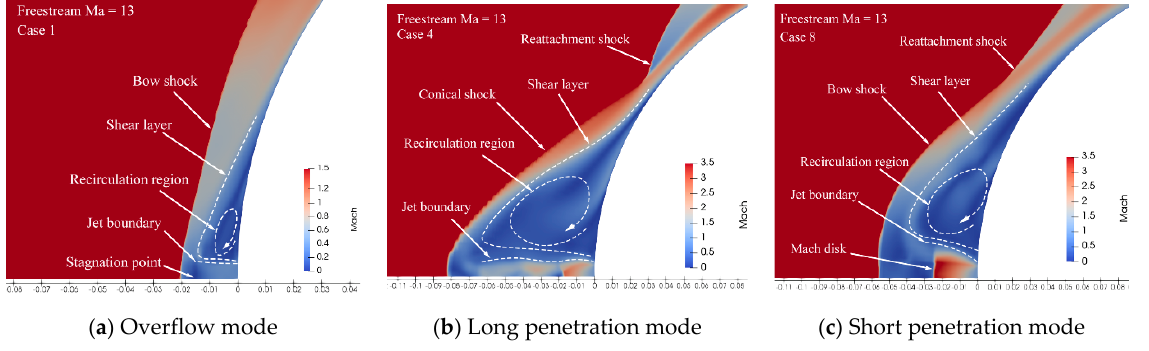
Figure 9. Interaction between freestream and R7 jet: ( a ) overflow mode, ( b ) LPM, ( c ) SPM.